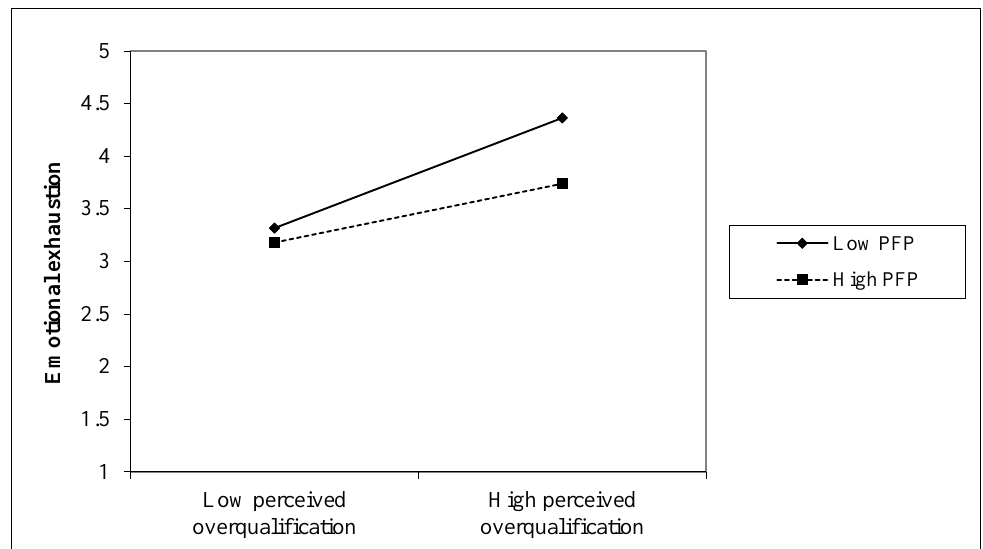
Figure 1. Moderating effect of PFP on the relationship between POQ and emotional exhaustion. Hypothesis 4 predicted that PFP moderates POQ’s indirect effect on creativity via emotional exhaustion, such that this indirect effect is more significant when PFP is low rather than when it is high. Bootstrapping procedures were used to interrogate Hypothe- tional indirect effects at different values of pay for performance. It reveals that, at high levels of PFP, the indirect effect of POQ on creativity through emotional exhaustion was